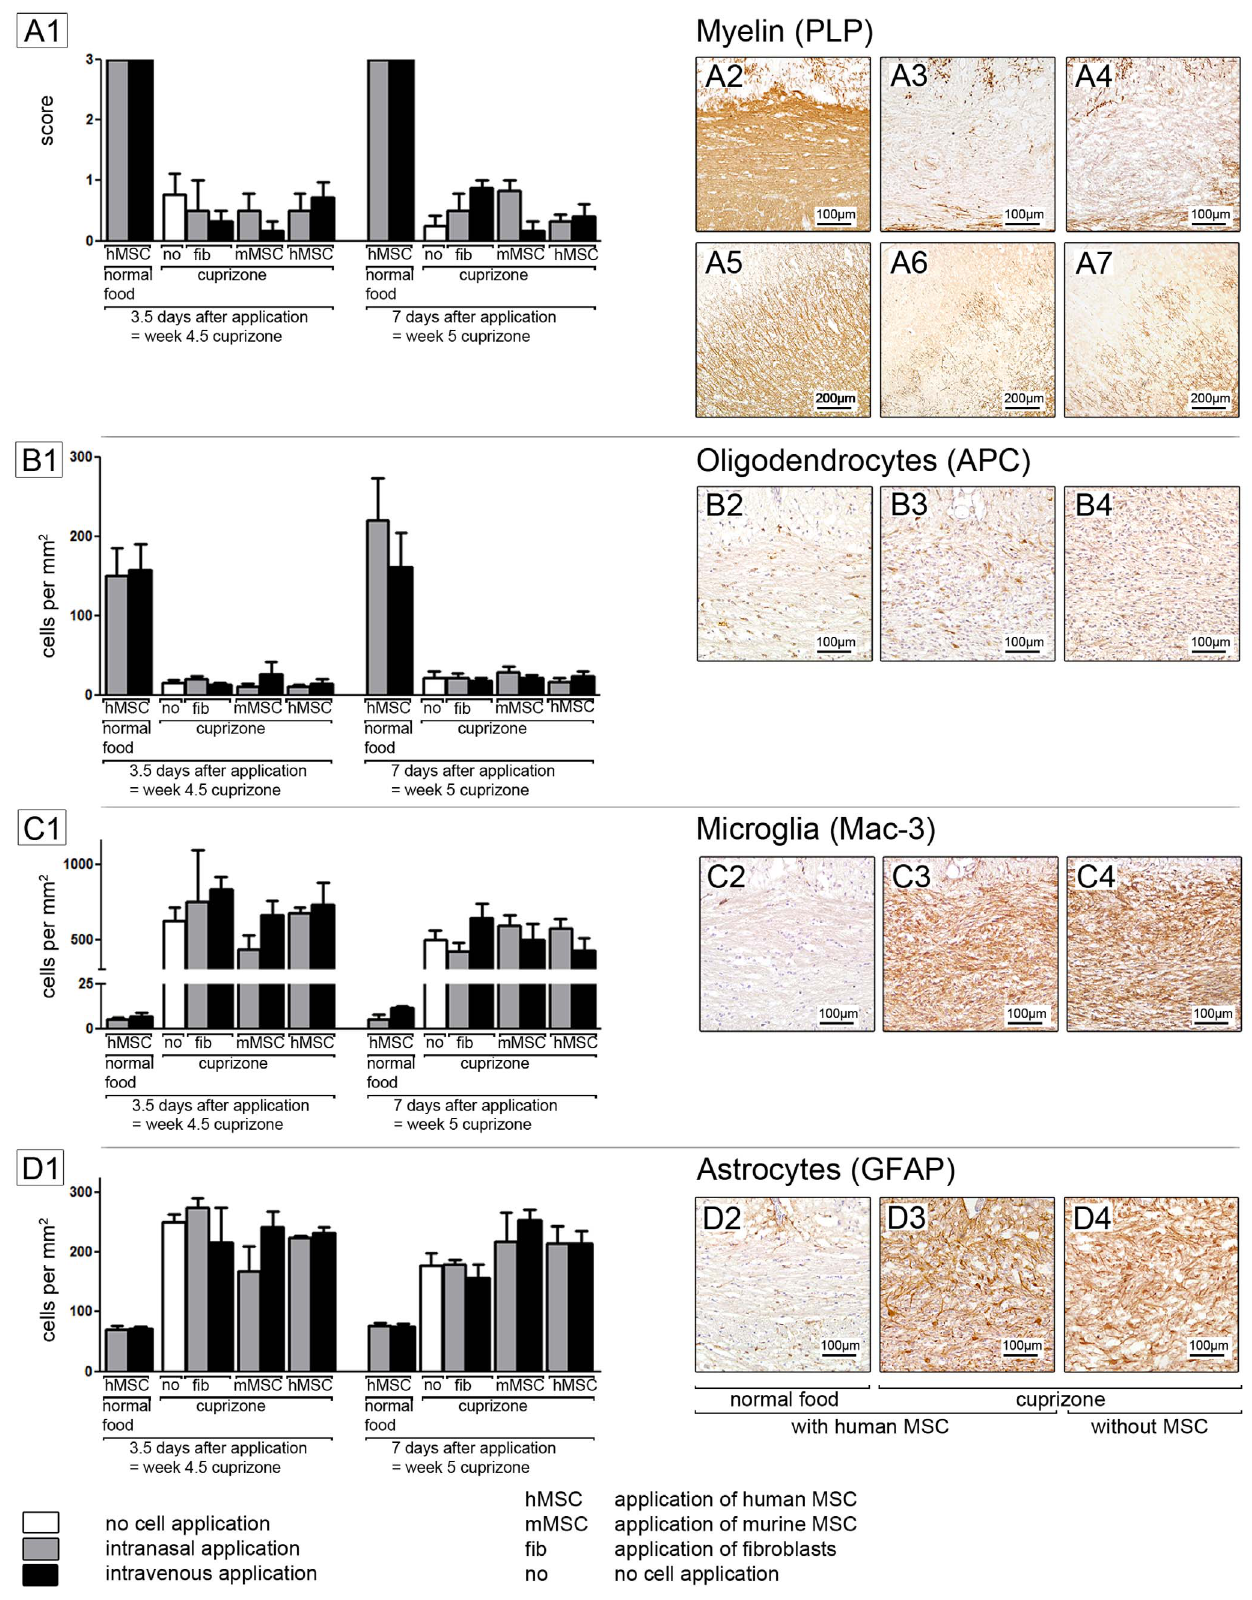
Figure 1. Immunohistochemical staining. MSC do not affect demyelination ( A1 ) neither death of oligodendrocytes ( B1 ). There is no impact of MSC on glial activation ( C1, D1 ). Each bar represents the mean 6 SEM. DAB immunohistochemical stainings of myelin (A2–A7), oligodendrocytes